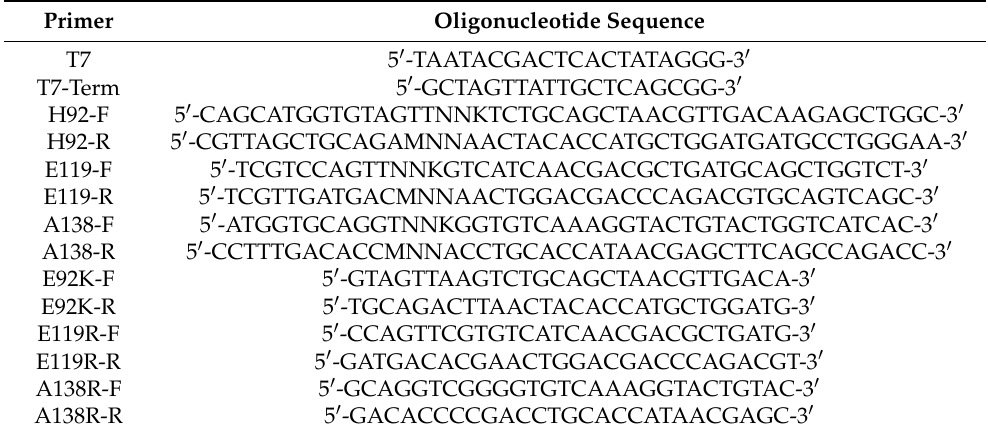
Table 2. PCR primers used for error-prone PCR and saturated site-directed